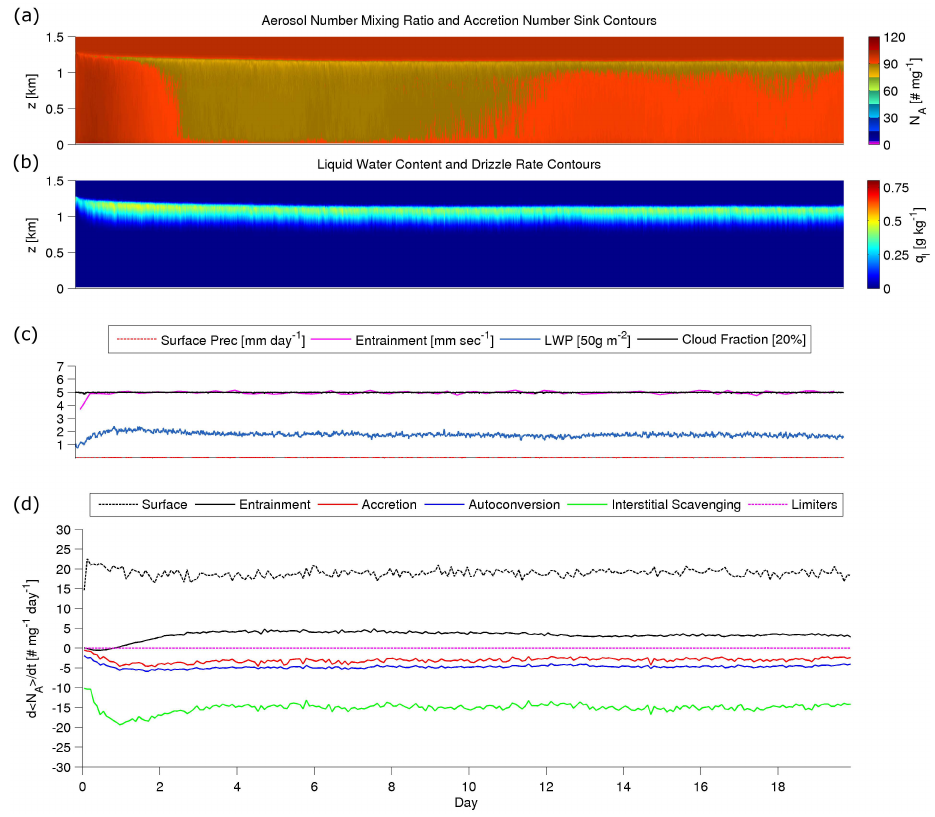
Fig. 7. Time-height plots and time series for run W6.5/NA100. Panels as in Fig.